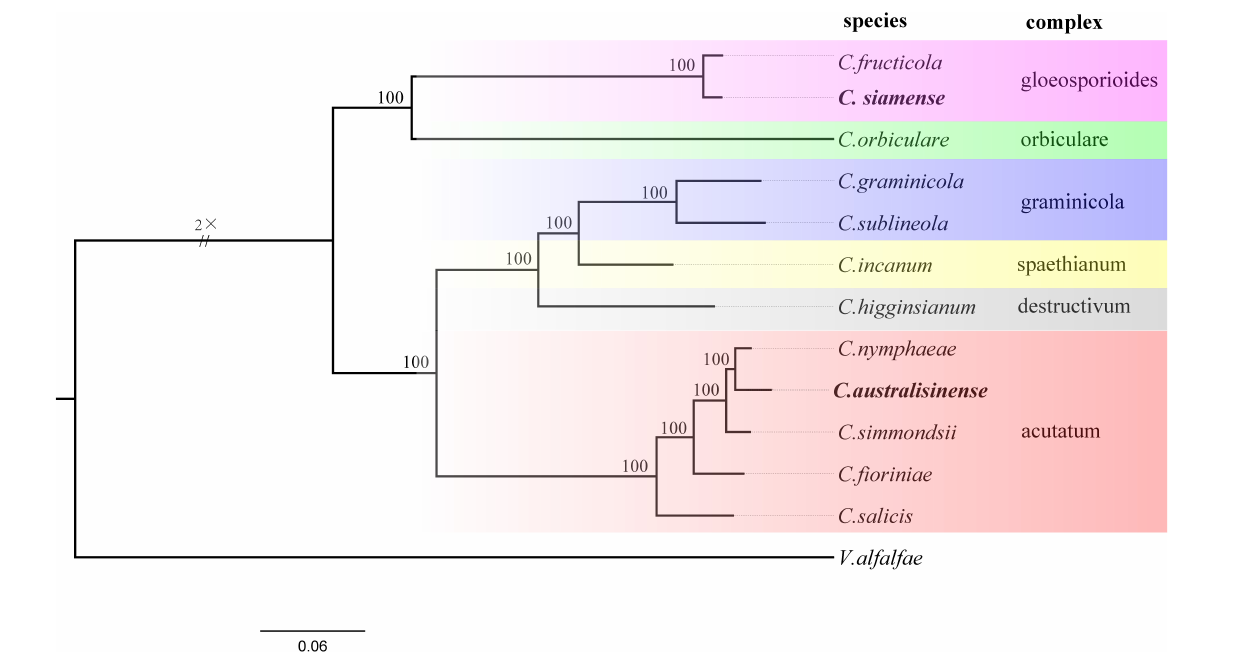
Frontiers in Microbiology |